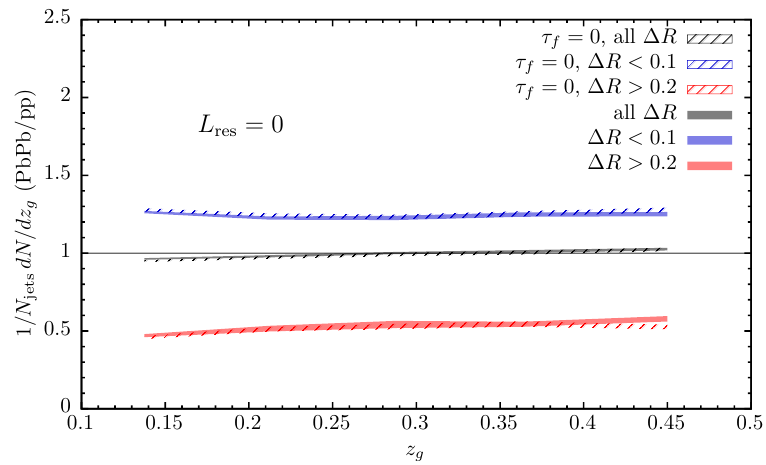
Figure 12 . Results for the ratio of the z g distribution of PbPb jets over that of pp jets for samples of jets with anti- k T radius R = 0 : 4, with di(cid:11)erent angular separation (cid:1) R between the two branches that satisfy the Soft Drop condition (4.1), using the (cid:13)at grooming procedure. Each individual curve is normalized to the total number of jets analyzed, N jets . We compare results for the completely resolved case L res = 0 between two di(cid:11)erent scenarios: the physical one, with dynamical space-time evolution of the parton shower, depicted with solid bands, versus an unphysical scenario where all on-shell partons are assumed to have been created at the space-time position of the hard scattering, with formation time zero, depicted in dashed bands and labelled as (cid:28) f = 0. The solid bands are the same as those in the left panel of (cid:12)gure